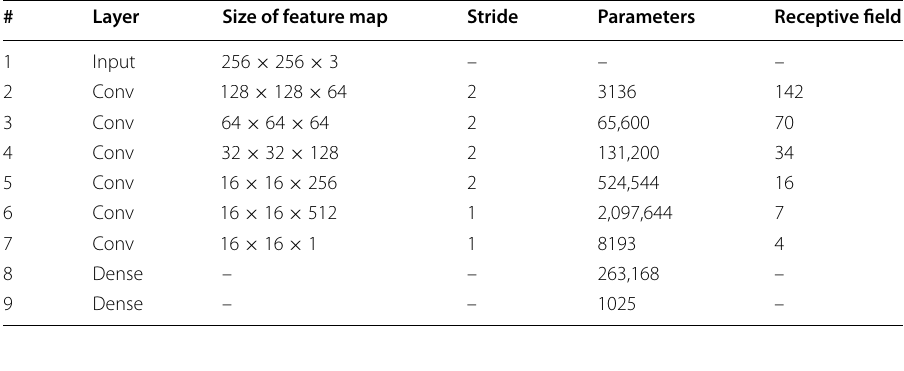
Table 1 Structure of discriminator